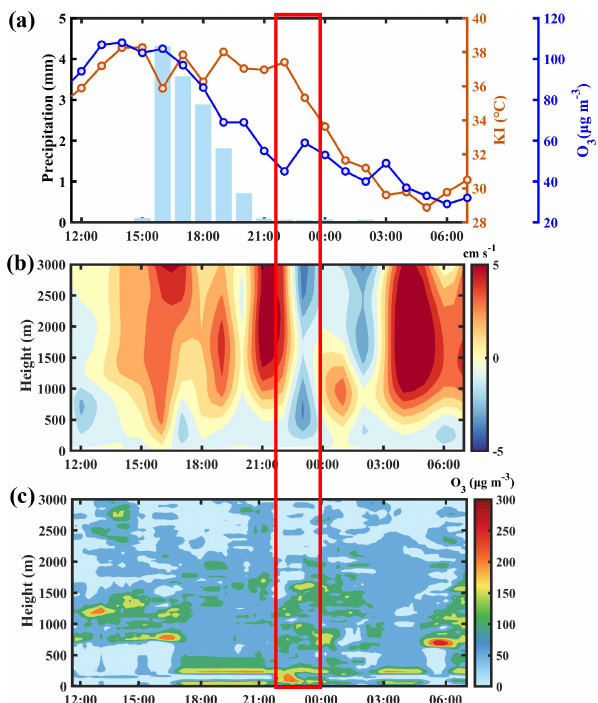
Figure 8. (a) Hourly variations of KI (brown line), O 3 concentra- tions (blue line), and hourly precipitation amount (blue bar); (b) vertical wind velocity with positive and negative values related to updrafts and downdrafts; and (c) vertical profile of O 3 concentra- tions at the NCYL site in Dongguan on 3–4 September